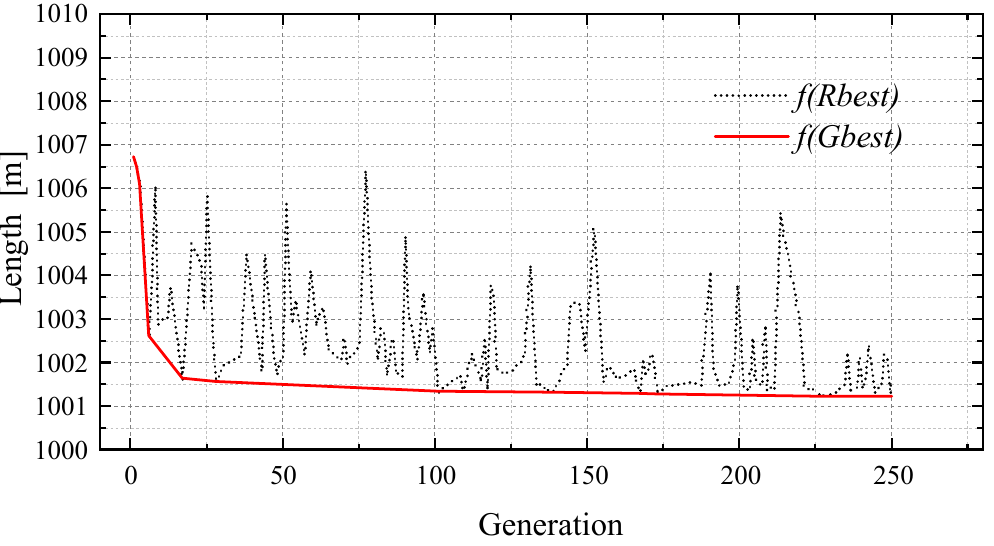
Figure 15. The convergence progress of searching optimal length after 250 iterations.